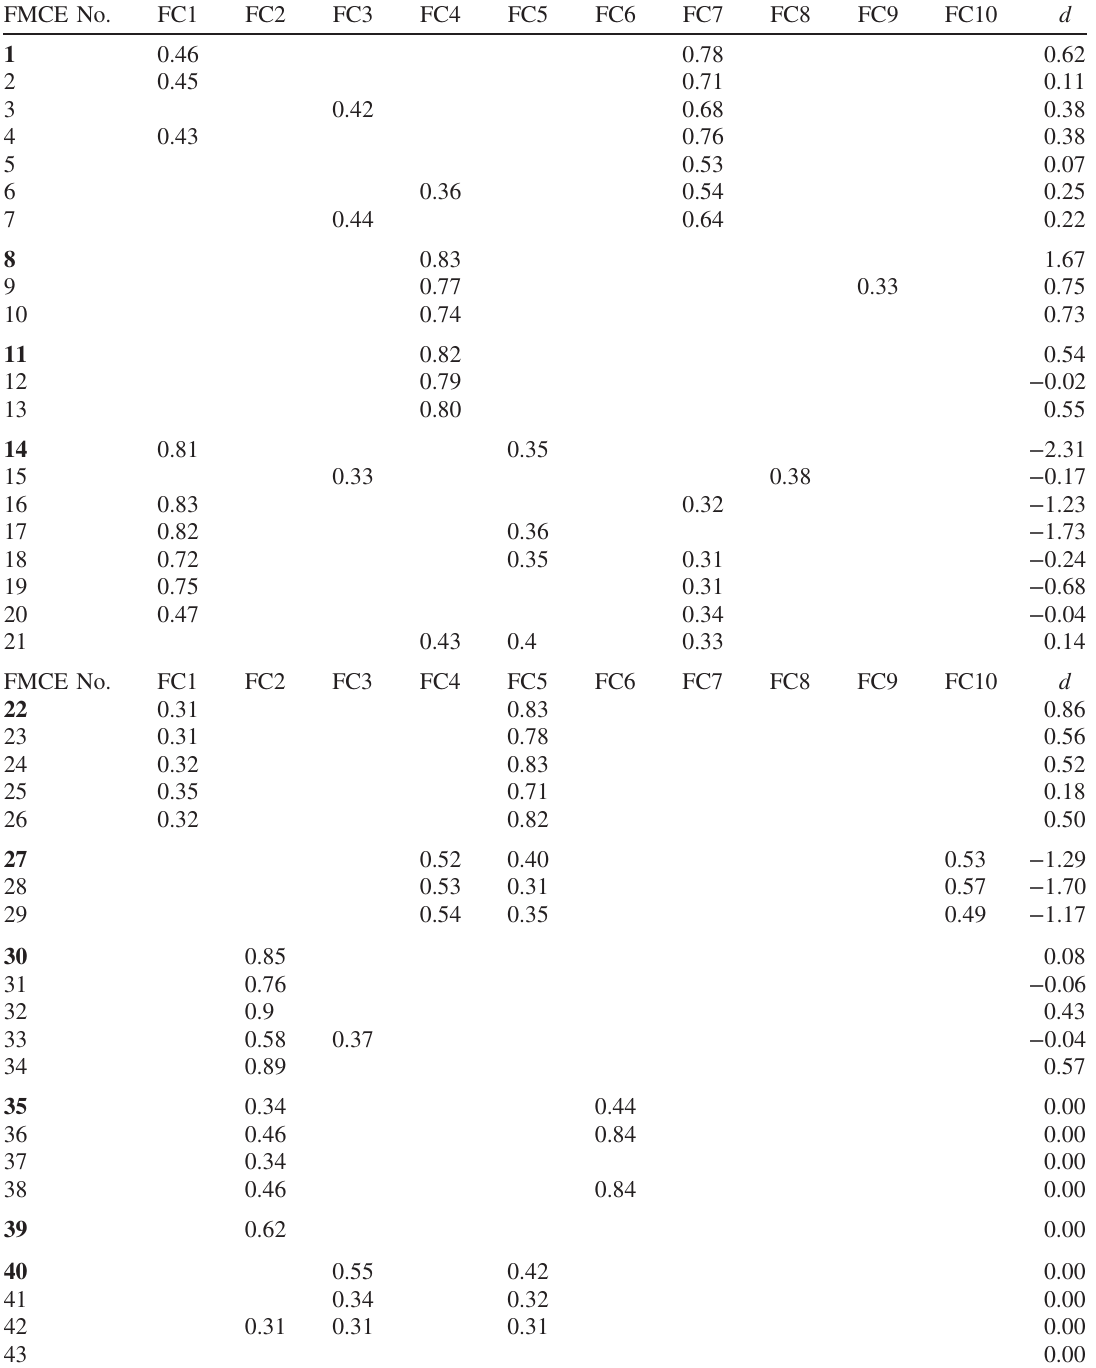
TABLE III. Factor loadings the for 10-factor exploratory factor analysis performed with multidimensional IRT (varimax rotation). The bolded item numbers represent the start of item blocks which are also separated by horizontal lines. Loadings greater than 0.3 are shown. Larger values of d represent easier items. The horizontal header is repeated after item 21 to improve